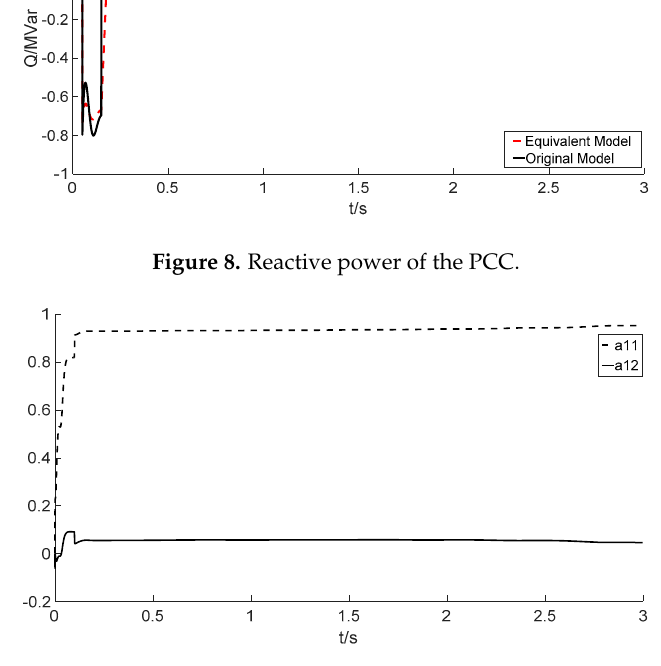
Figure 9. The parameter identification process.